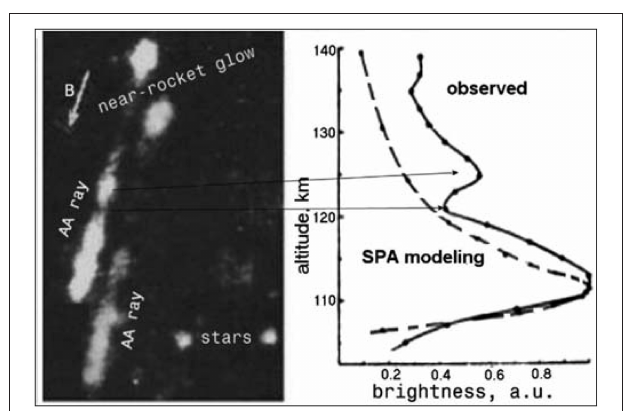
FIGURE 4 | (Left) An example of the near-rocket glow and Artificial Auroral rays in Zarnitza 2 (see text). (Right) The altitude-profile of the leftmost AA ray with a Monte Carlo profile superimposed. After Mishin et al. (1981). Reprinted by permission from